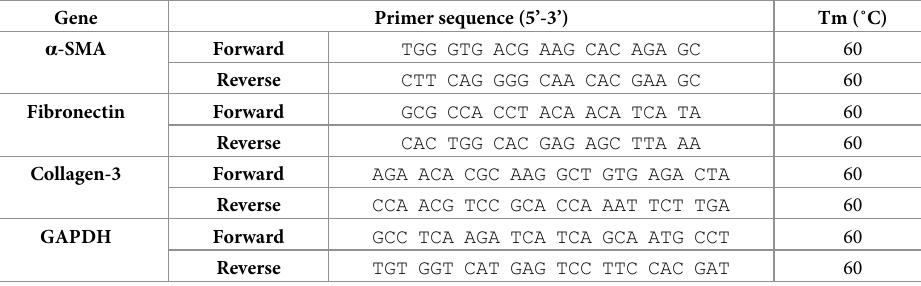
Table 1. Quantitative reverse transcription PCR primer